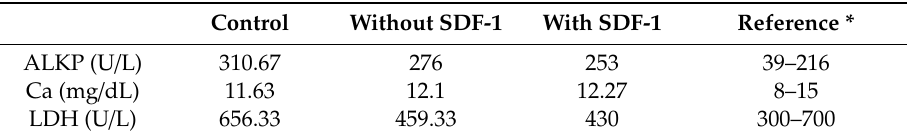
Table 1. Biochemistry test (one month).